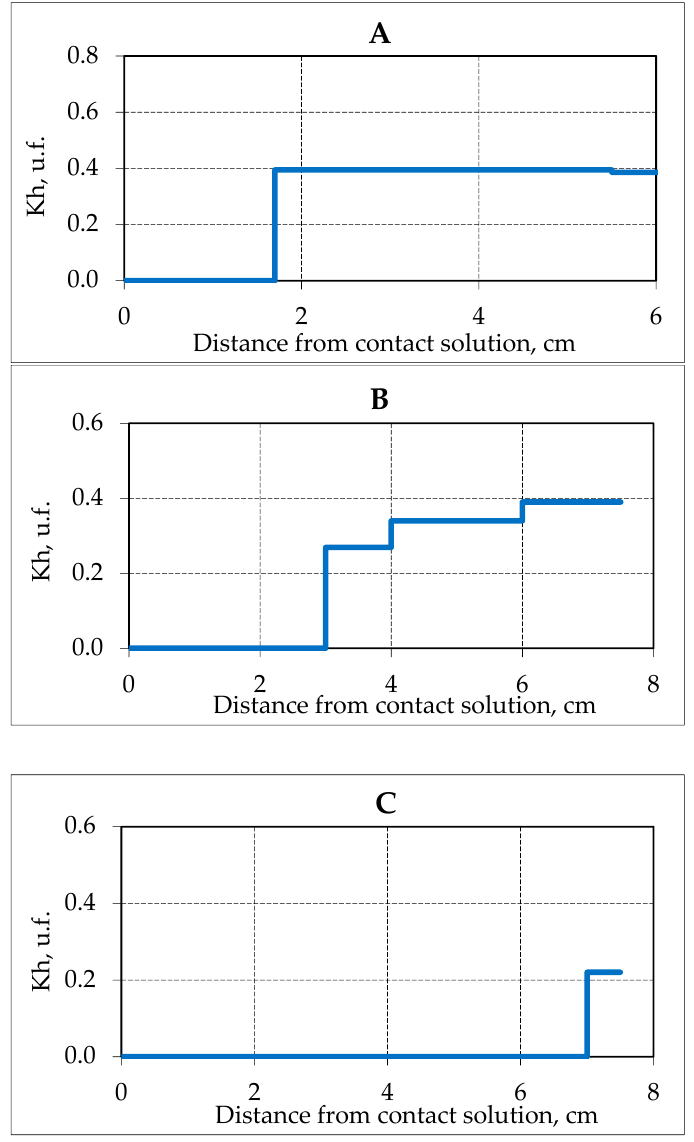
Figure 7. The change in the hydration coefficient (K h ) in samples of frozen hydrate saturated sand (sand 2, W = 16%) in time when interacting with 0.2 N NaCl solution at a temperature of − 2.5 °C. ( A – C ) is the time of interaction with the salt solution, respectively, 0.3; 0.9; 2.6 h.